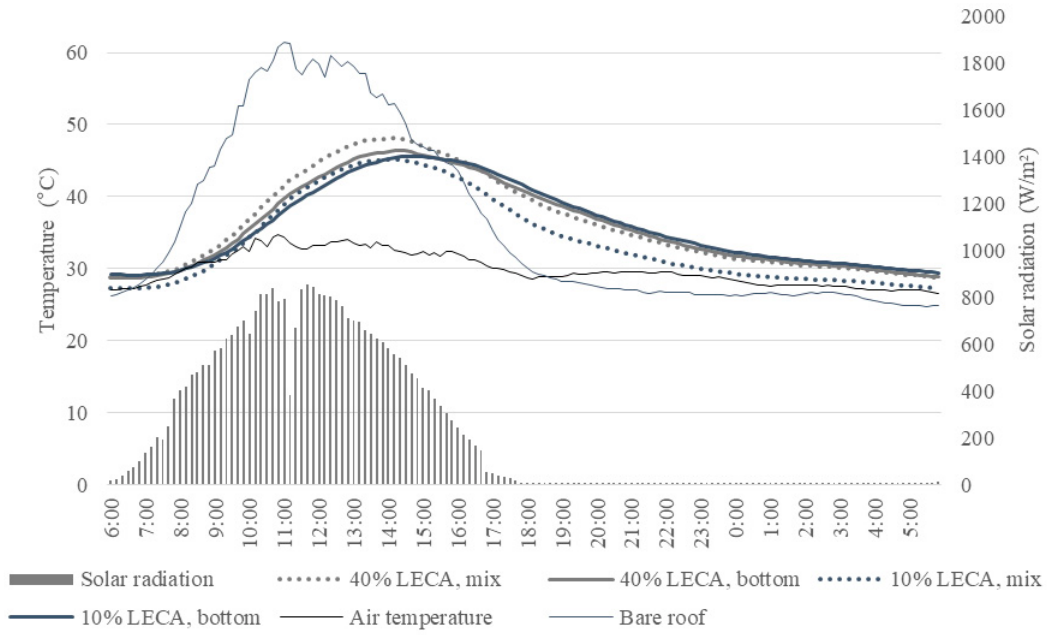
Figure 15. Temperatures and solar radiation in the cases of roofs with 10% and 40% LECA laid at the bottom without plants, and of 10% and 40% LECA mixed with the soil without plants (24 September 2017 06:08:41 to 25 September 2017 05:58:41).